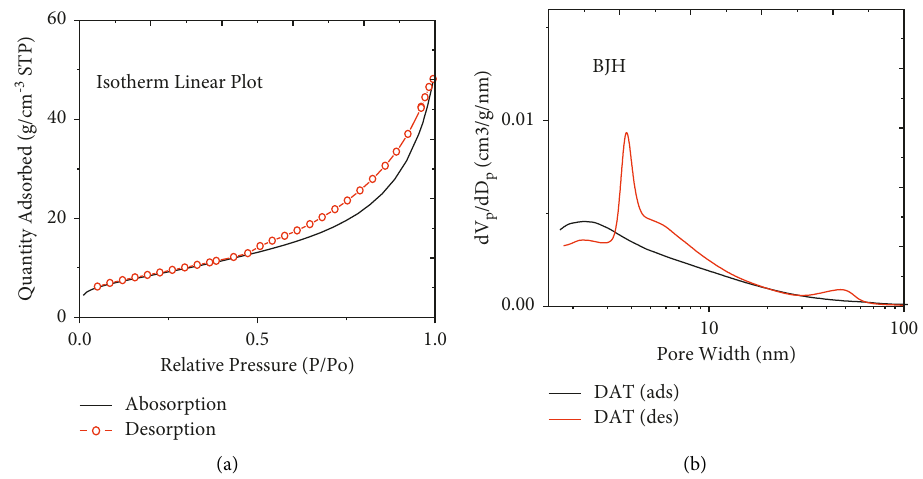
Figure 7: The nitrogen adsorption curve. Isotherm linear plot (a) and BJH adsorption d V /dlog ( w ) pore volume (b) of sample